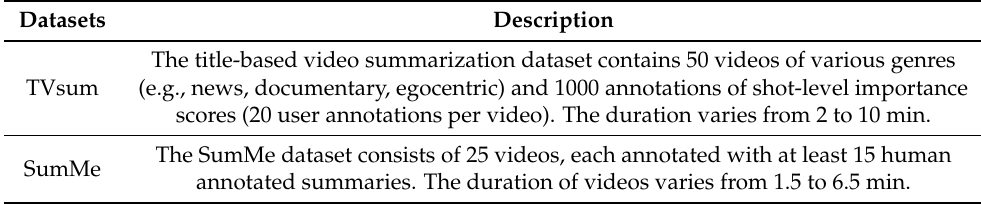
Table 1. Analysis of TVsum and SumMe